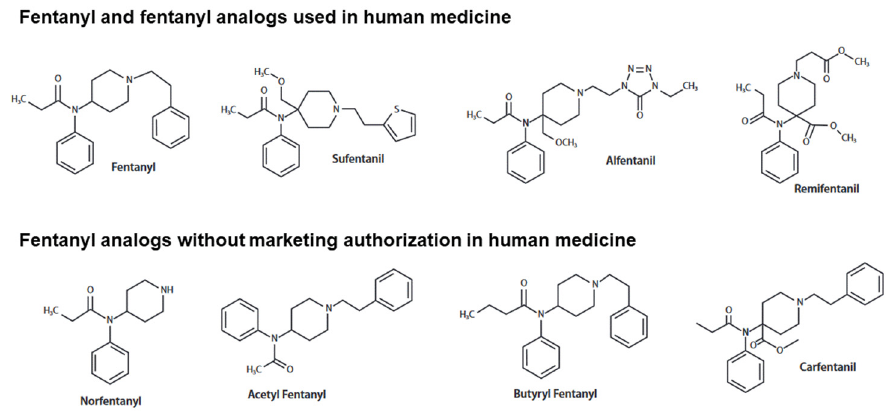
Figure 1. Chemical structure of fentanyl and the main fentanyl analogs.